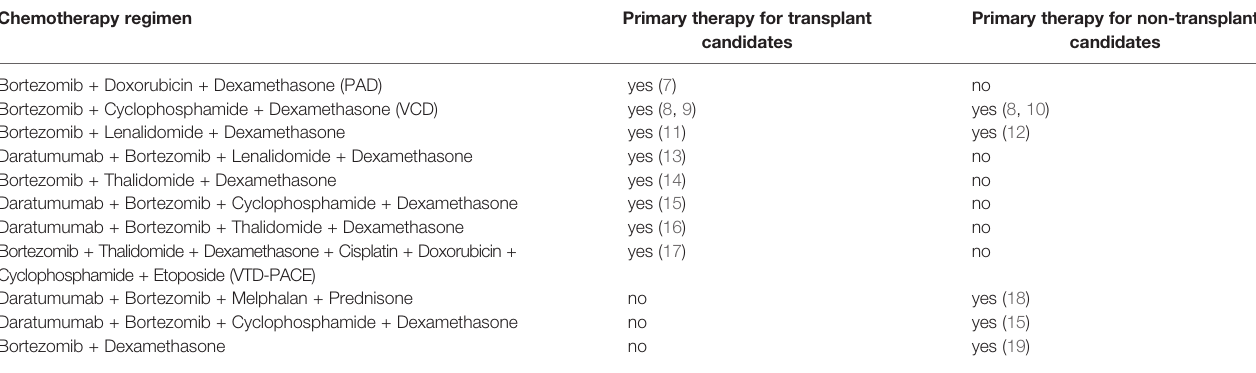
TABLE 1 | Bortezomib containing chemotherapy regimens currently in use for the fi rst-line treatment of multiple myeloma. Chemotherapy